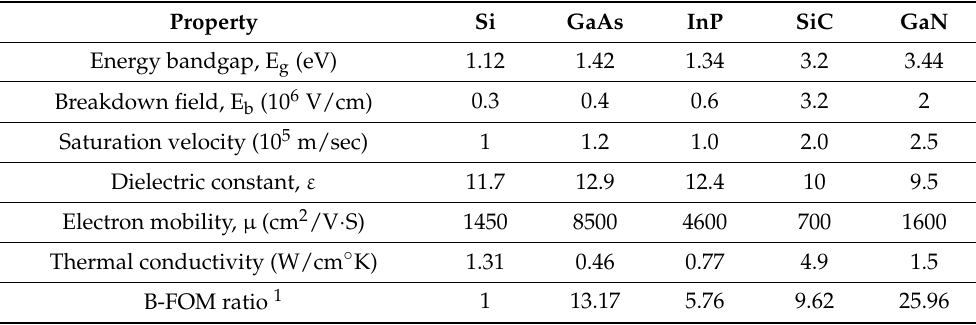
Table 1. Comparison of the material properties of various microwave semiconductors. Property Si GaAs InP Energy bandgap, E g (eV)